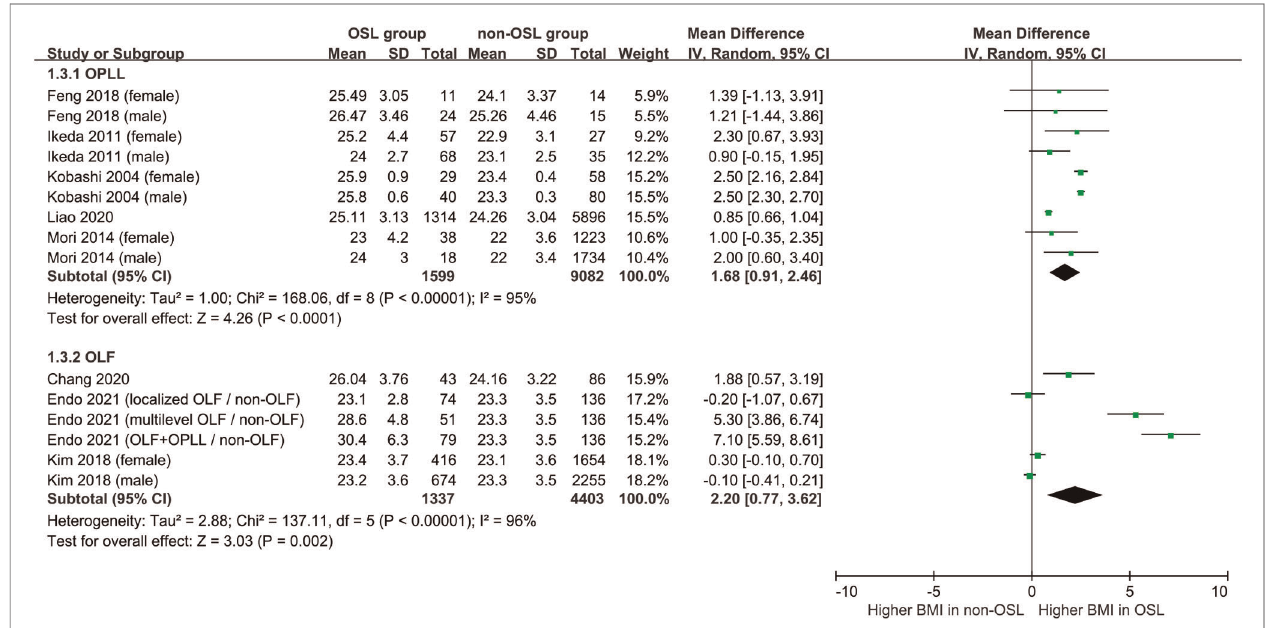
FIGURE 4 | Subgroup analysis strati fi ed by the type of OSL for the relationship of BMI with the onset of OSL ( top , OPLL; bottom ,